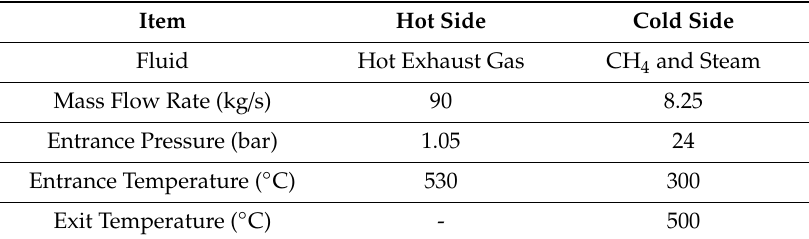
Table 4. Design conditions of the chemical